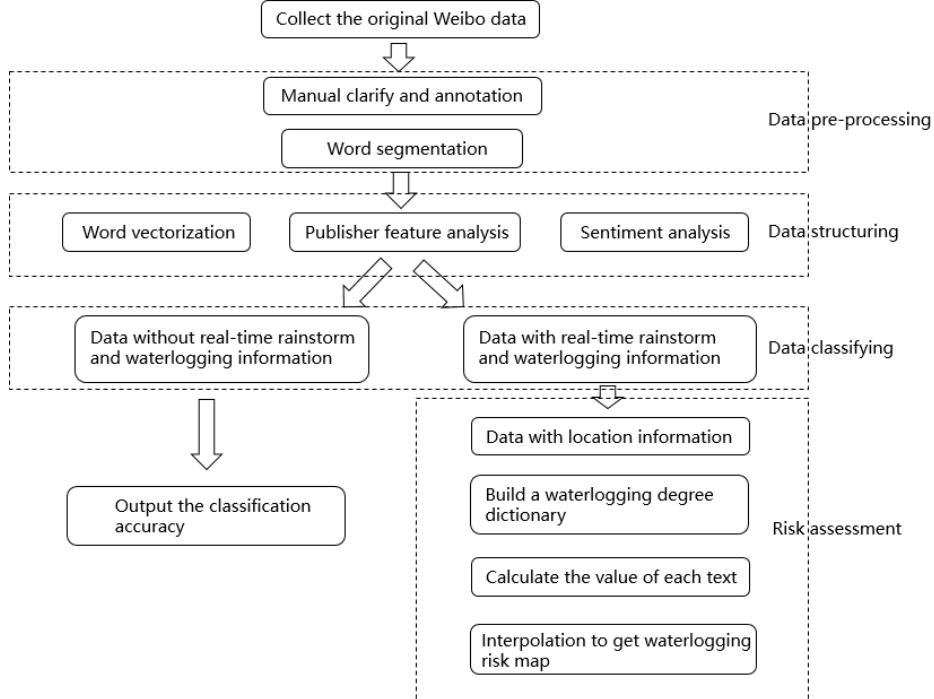
Figure 1. The overall model